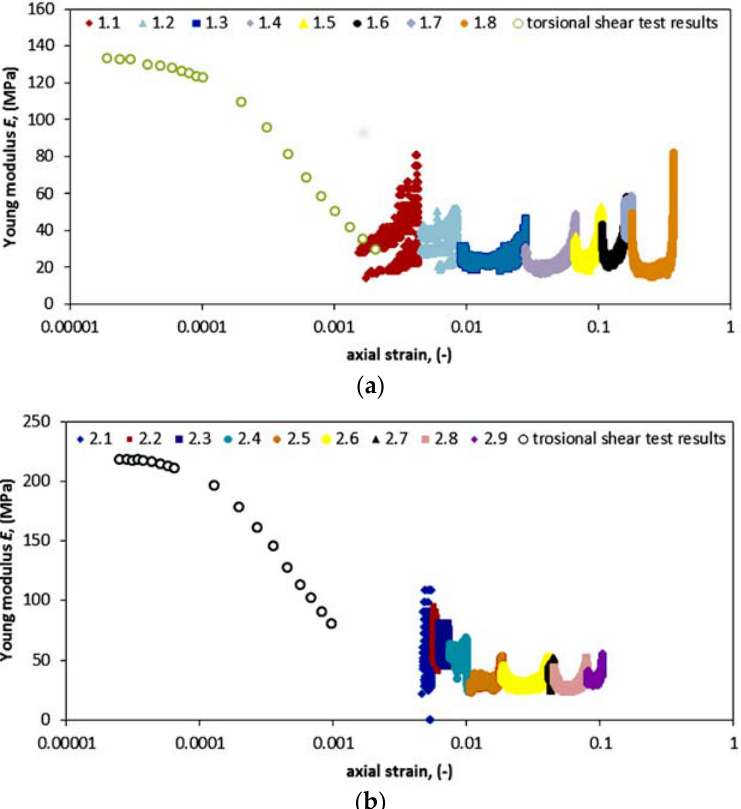
Figure 12. Modulus value versus axial strain of tested sandy clay for different conditions: radial stress σ ’ 3 equal to ( a ) 45 kPa and ( b ) 90 kPa, as defined in Table 2.